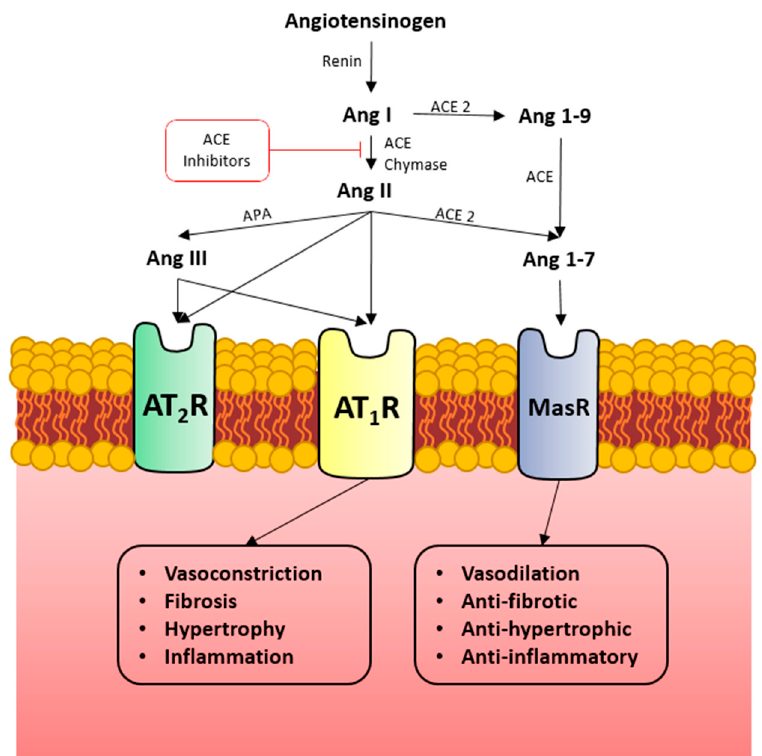
Figure 1. Angiotensin-converting enzyme 2 (ACE2) functions by converting Angiotensin 1 (Ang I) and Angiotensin 2 (Ang II) to Angiotensin 1–9 (Ang 1–9) and Angiotensin 1–7 (Ang 1–7), respec- tively. Ang 1–9 can further be converted to Ang 1–7; Ang 1–7 acts at the MAS1 oncogene (MasR).